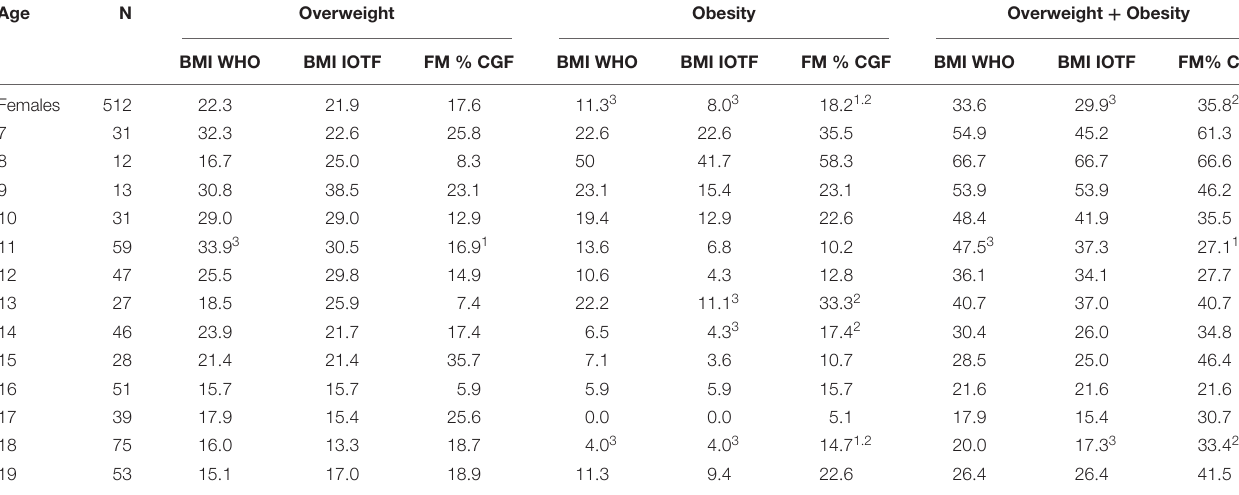
TABLE 2 | Prevalence (%) of overweight and obesity of females by age ( N = 512). Age N Overweight Obesity